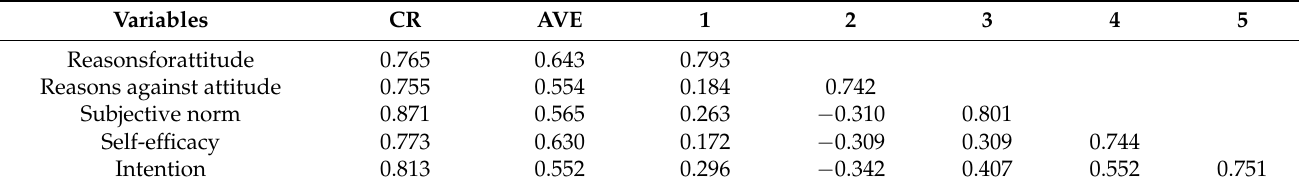
Table 1. Composite reliability, average variance extracted and discriminate